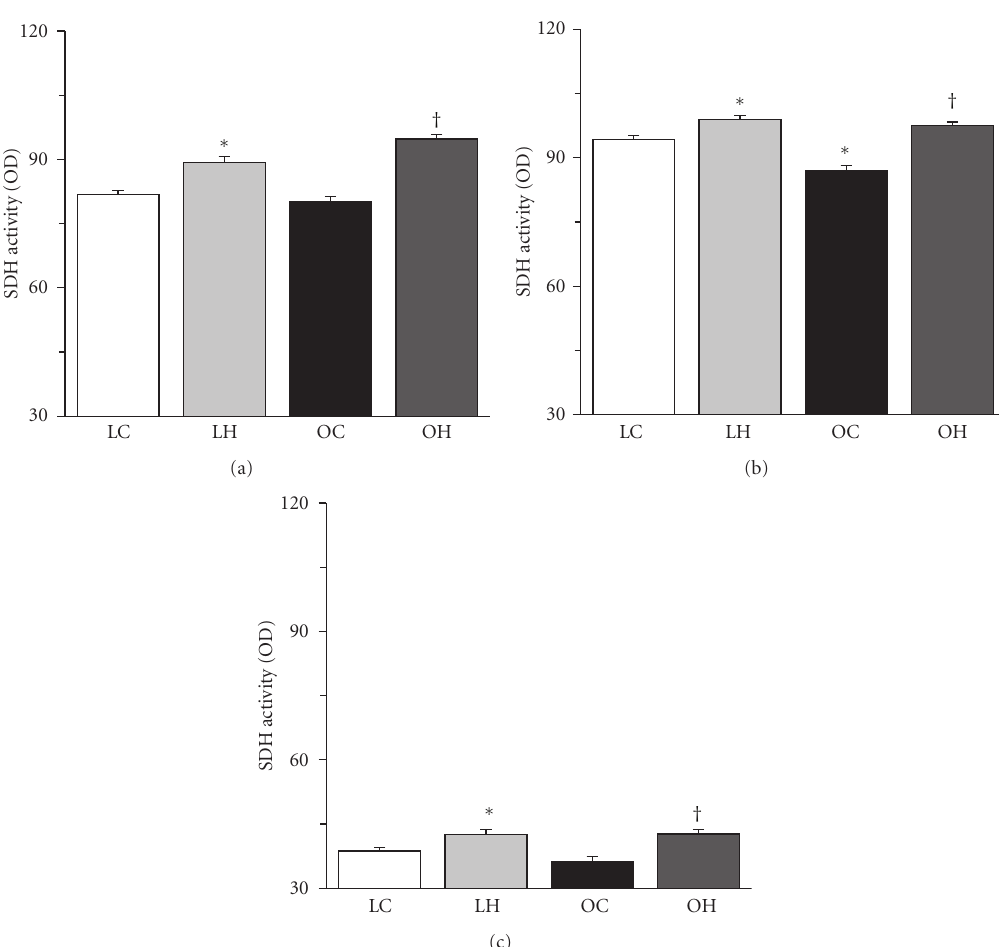
Figure 5: SDH activities of type I (a), IIA (b), and IIB (c) fibers in the extensor digitorum longus muscle. The values of SDH activity are presented as the mean ± SEM. ∗ and † are significantly di ff erent from the LC and OC groups, respectively, at P < 0 . 05. In each muscle fiber type, over 100 muscle fibers were